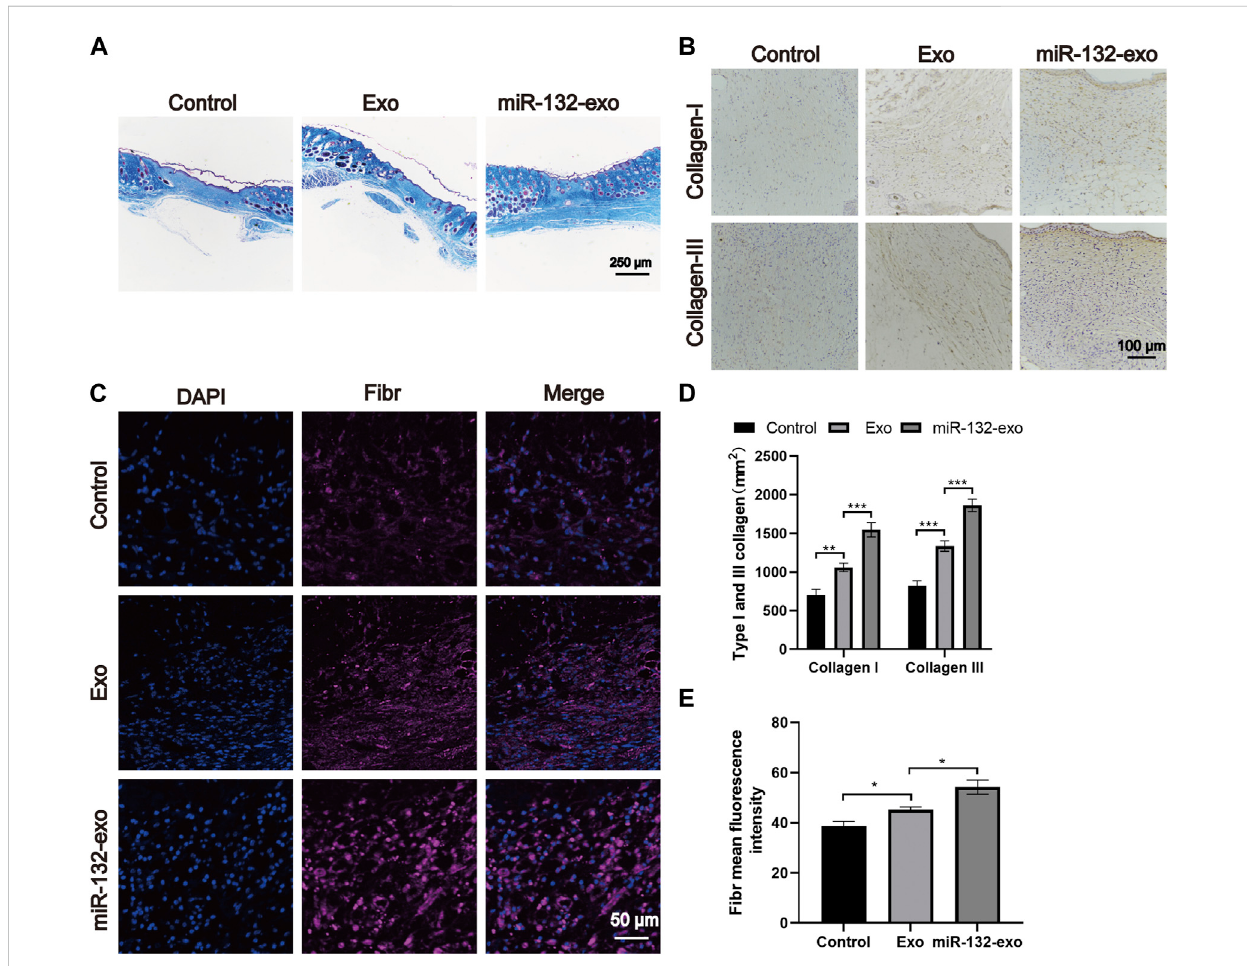
FIGURE 8 ThemiR-132-exopromotedcollagendepositionandECM fi bronectinaccretionindiabeticwounds. (A) RepresentativeimagesofMassonstainingin each group on day 14, scale bar = 250 μ m; (B) Representative images of immunohistochemistry staining of collagen I and collagen III in each group on days 14, scale bar = 100 μ m; (C) Representative images of Fibronectin immunostaining in each group on day 14, scale bar = 50 μ m; (D) Quantitative